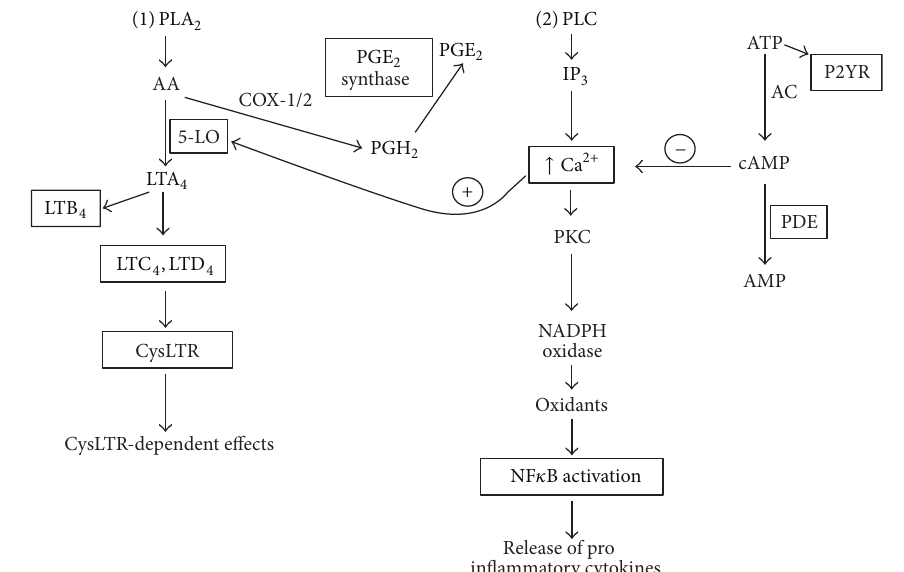
Figure 1: Cysteinyl leukotriene receptor-1-independent and -dependent anti-inflammatory activities of montelukast, pranlukast, and zafirlukast. The intracellular signalling pathways are depicted with the targets of the cysLTR1 antagonists indicated by means of a rectangle. Phospholipase A 2 (PLA 2 ) activation that is represented in pathway 1 during which membrane phospholipids are converted to arachidonic acid (AA), which is subsequently metabolized to either leukotrienes (LTA 4 , LTB 4 , and LTC 4 ) or prostaglandins (PGH 2 ) by 5-lipoxygenase (5-LO) and COX-1/2 enzymes, respectively. PGH 2 is converted to PGE 2 by PGE 2 synthase. Phospholipase (PLC) activation is represented in pathway 2 with the generation of inositol triphosphate (IP 3 ) which releases cytosolic Ca 2+ from storage vesicles with subsequent downstream activation of PKC, NADPH oxidase, 5-LO, and NF 𝜅 B, with release of proinflammatory cytokines. ATP binds to purinergic receptors (P2YR) and is also converted to cyclic AMP by adenylate cyclase (AC) which is degraded by intracellular phosphodiesterases (PDE). Cyclic AMP downregulatestheCa 2+ -mediatedactivationof5-LOandNADPHoxidase. InhibitionofcysLTR1receptorsattenuatesthereceptor-dependent effects of cysteinyl